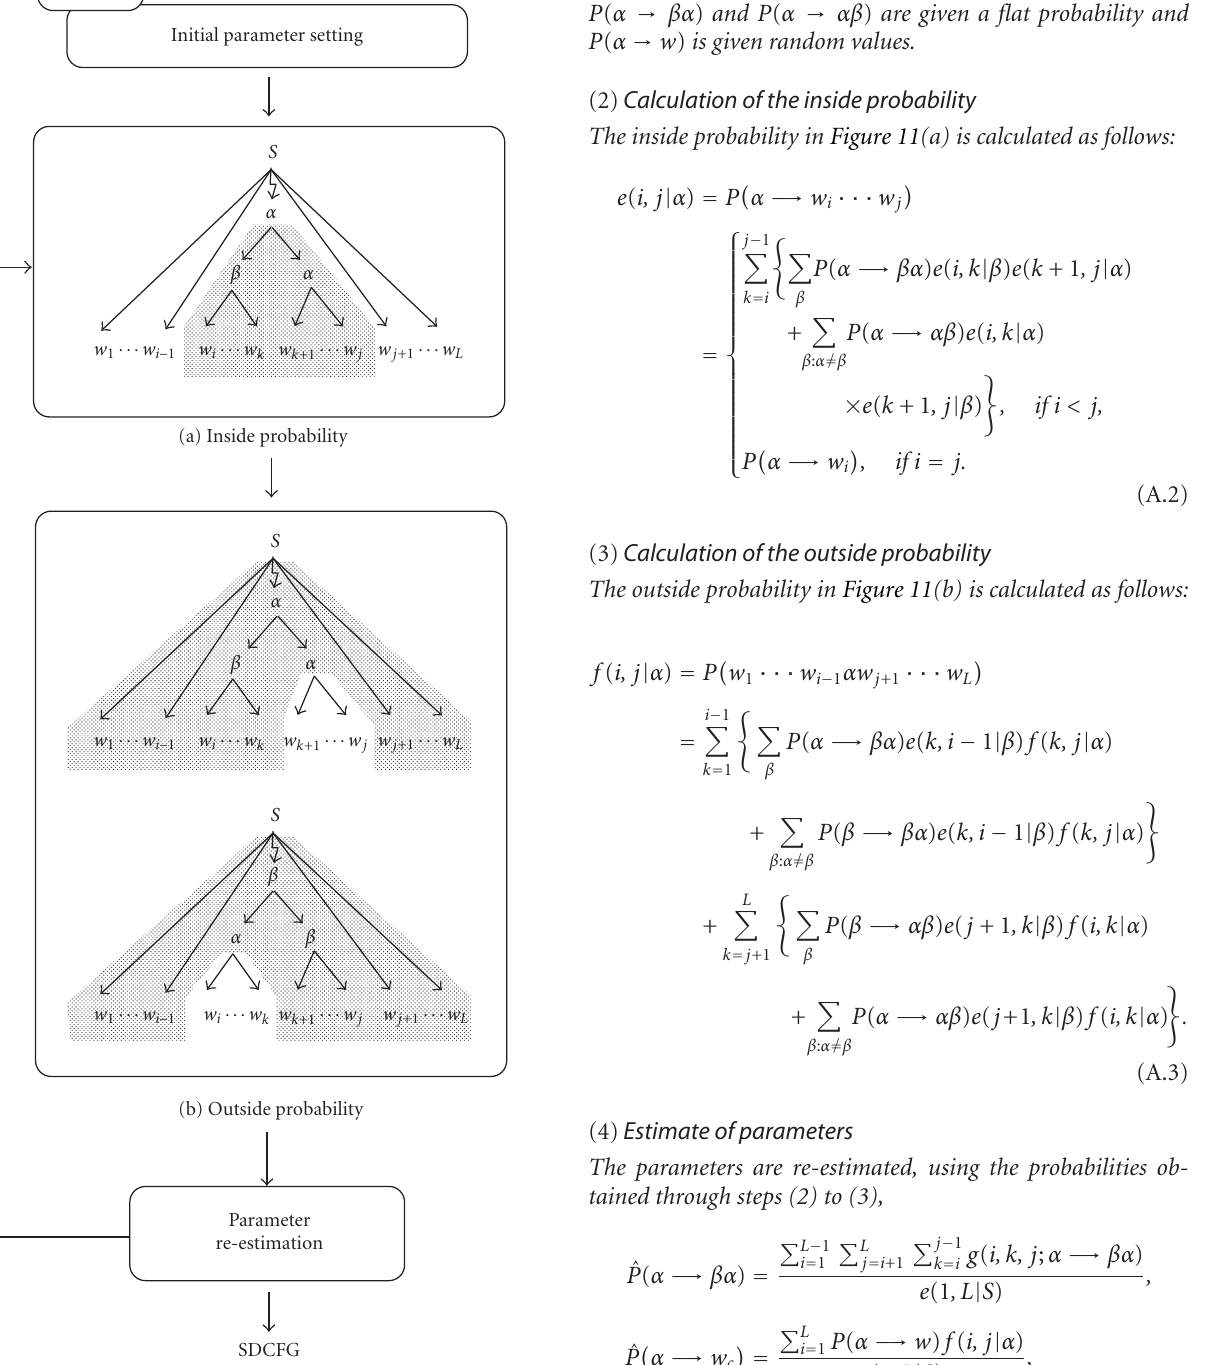
Algorithm A.3. (1)